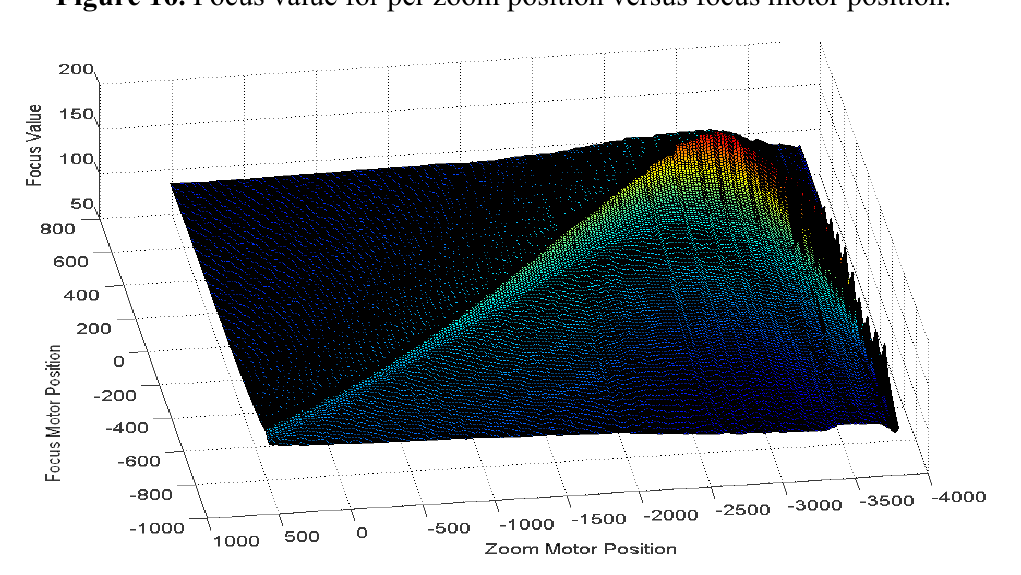
Figure 16. Focus value for per zoom position versus focus motor